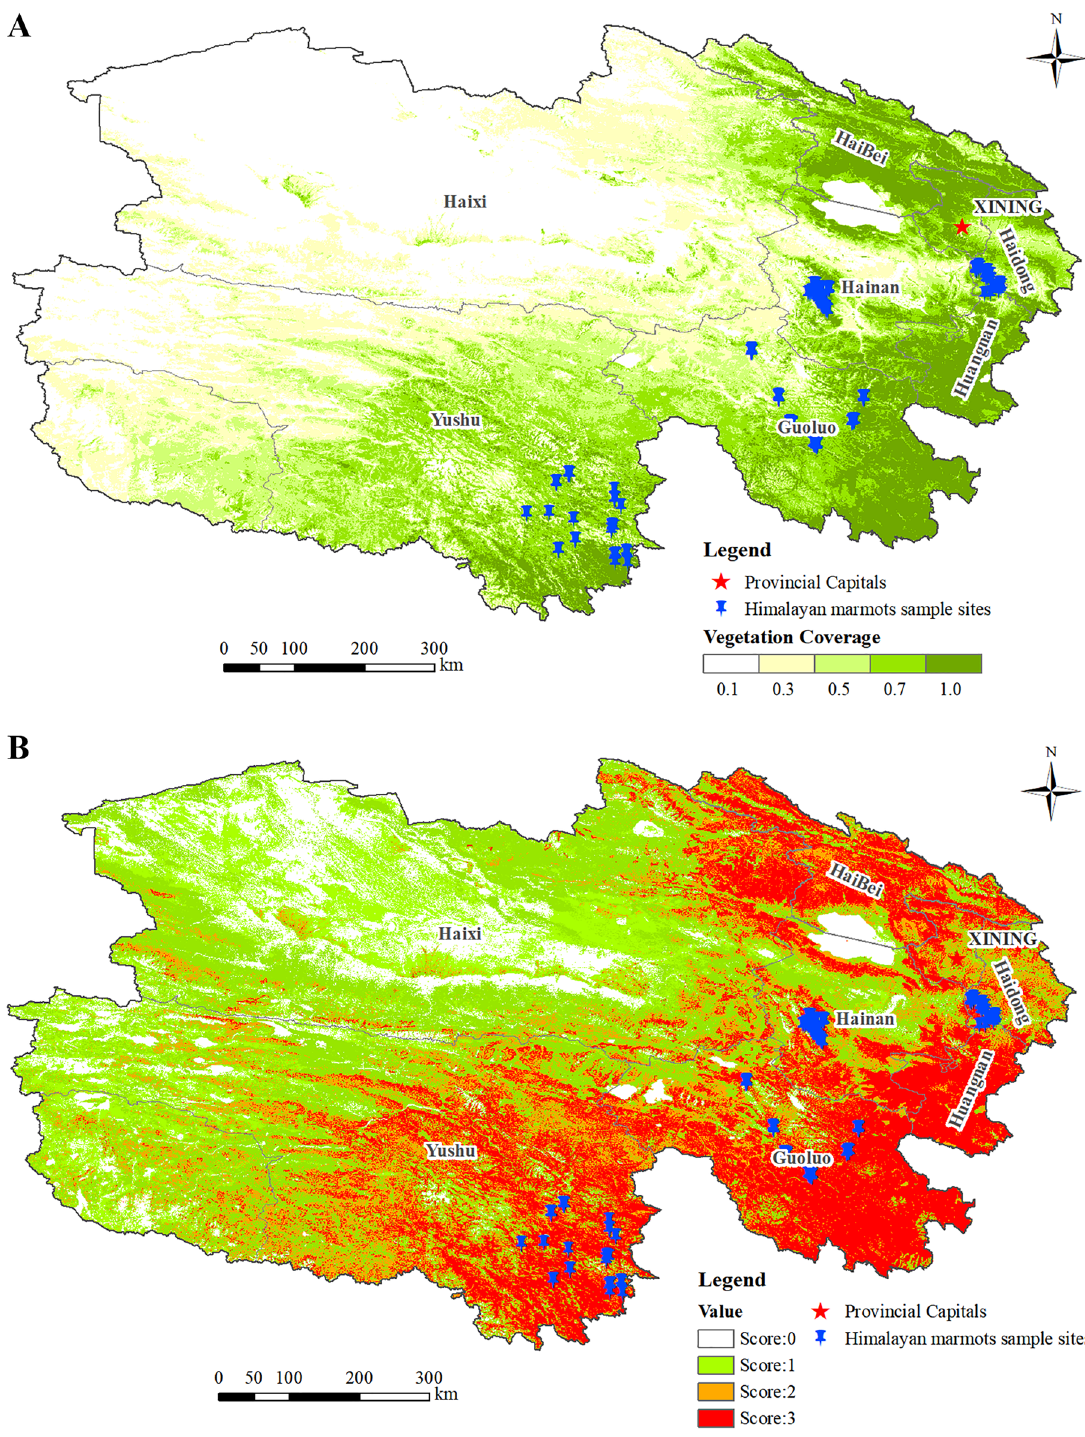
Figure 3. Vegetation cover in Qinghai Province ( A ); Reclassification of vegetation cover ( B